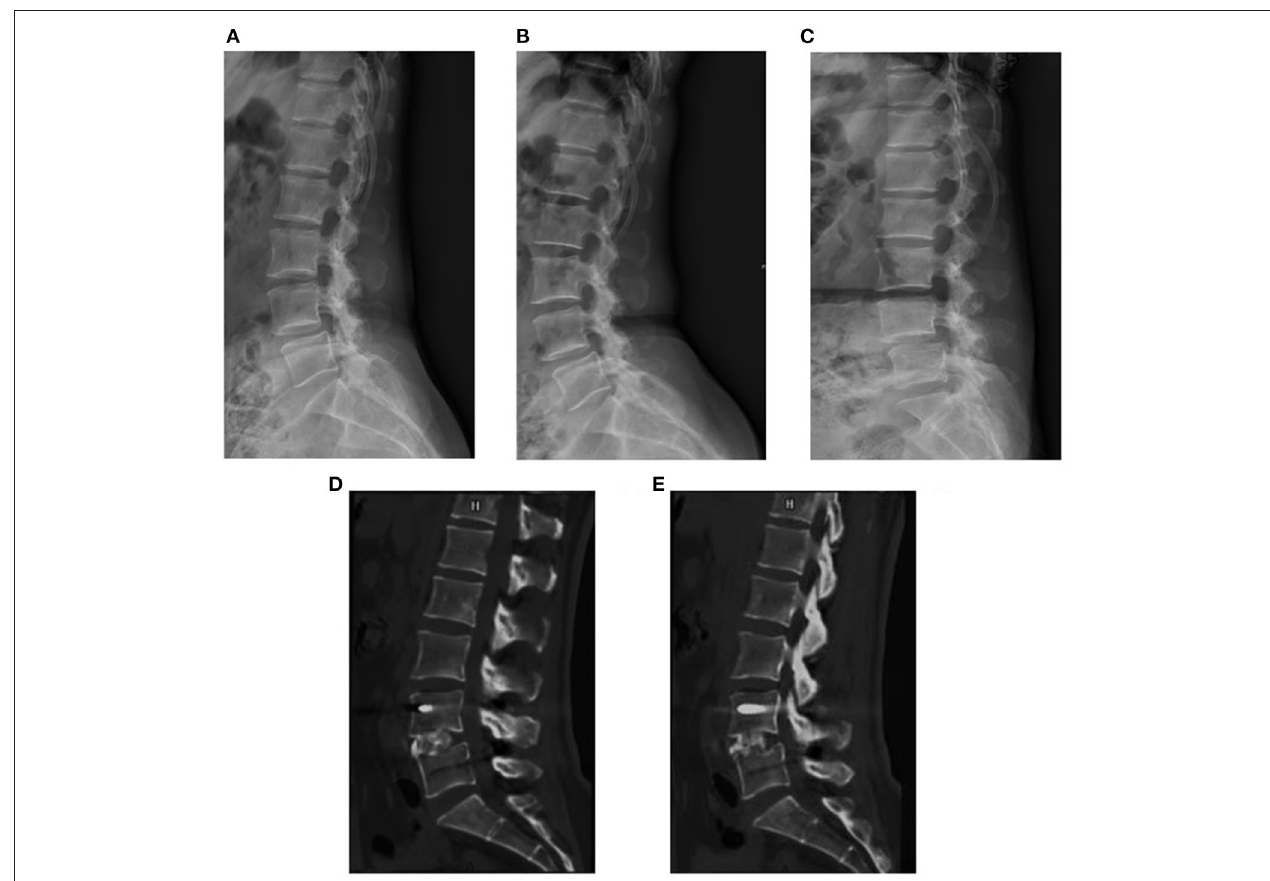
FIGURE 6 | The expandable tube consists of a rigid tubule with an opening at the distal side and a flexible baffle (A,B) . The tube expands when the cage is inserted, establishing a safe working space (C) .